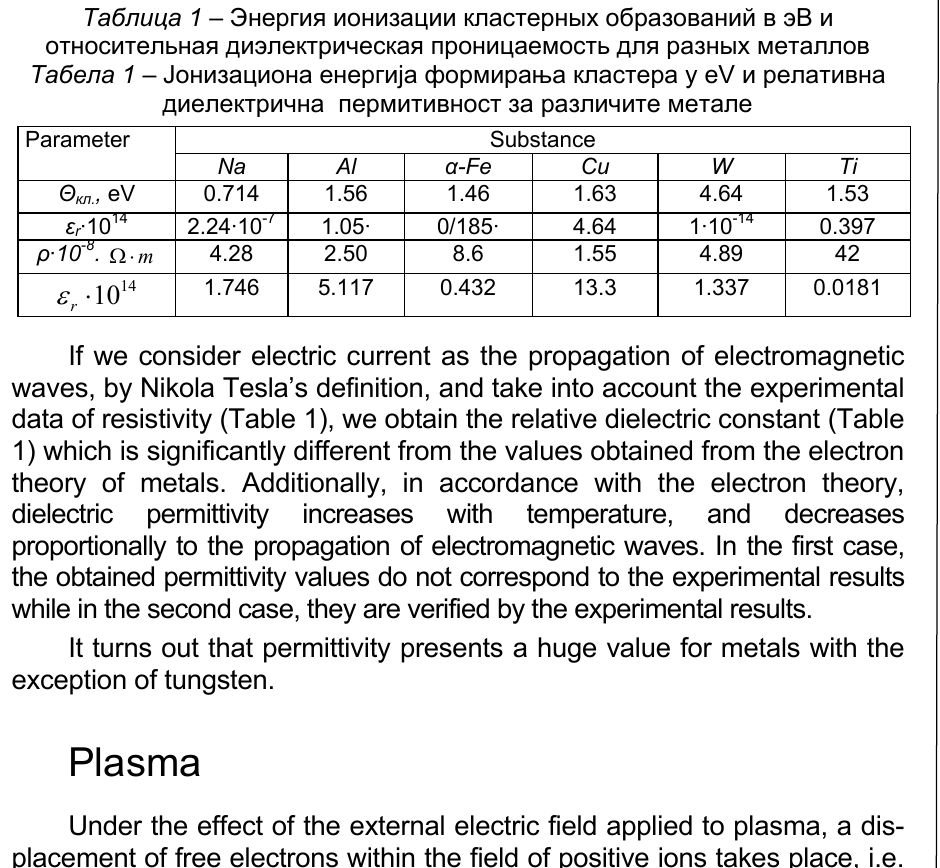
Table 1 – Ionization energy of cluster formations in eV and relative